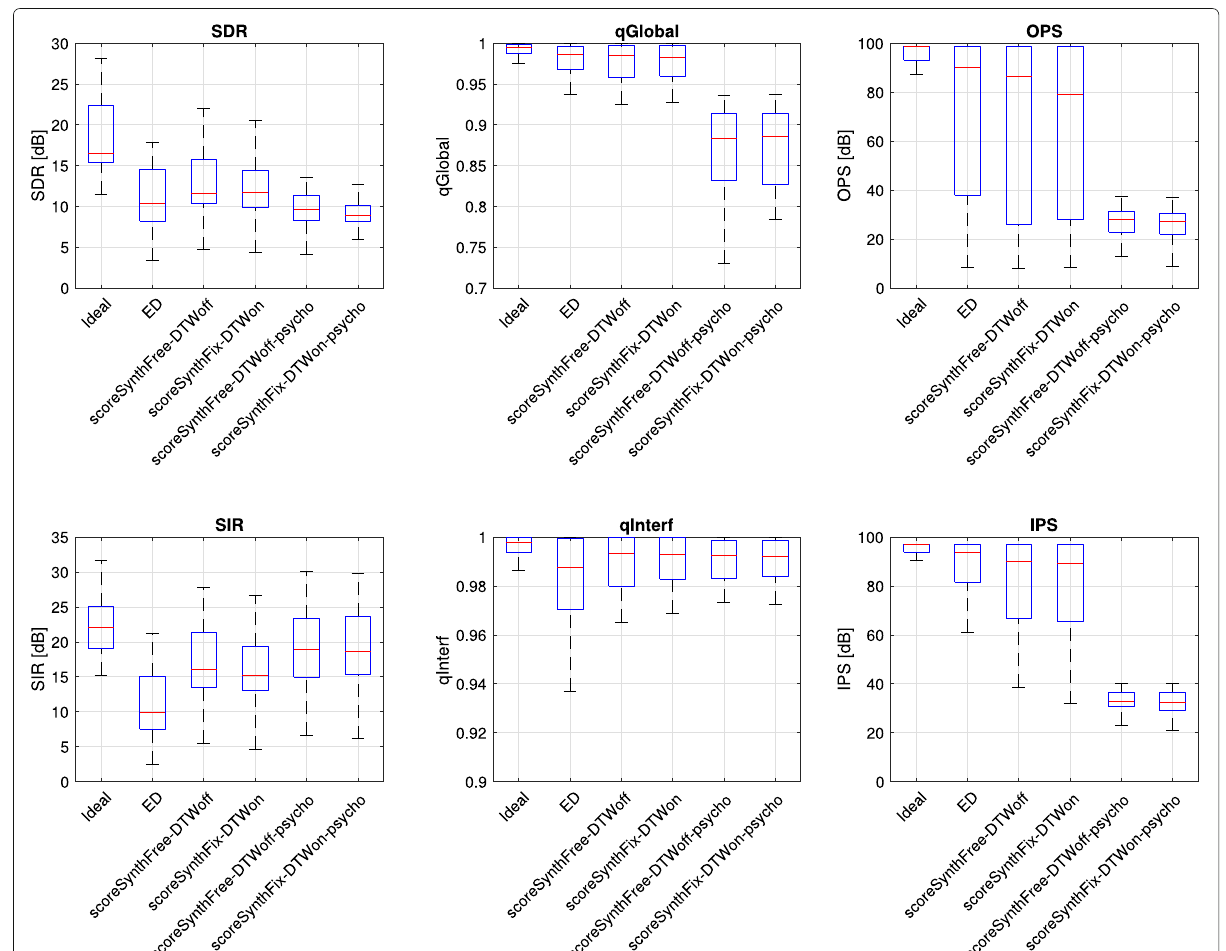
Fig. 10 Objective and perceptual results for minus one application using the BBS_EVAL metrics and the PEASS metrics for the orchestra dataset